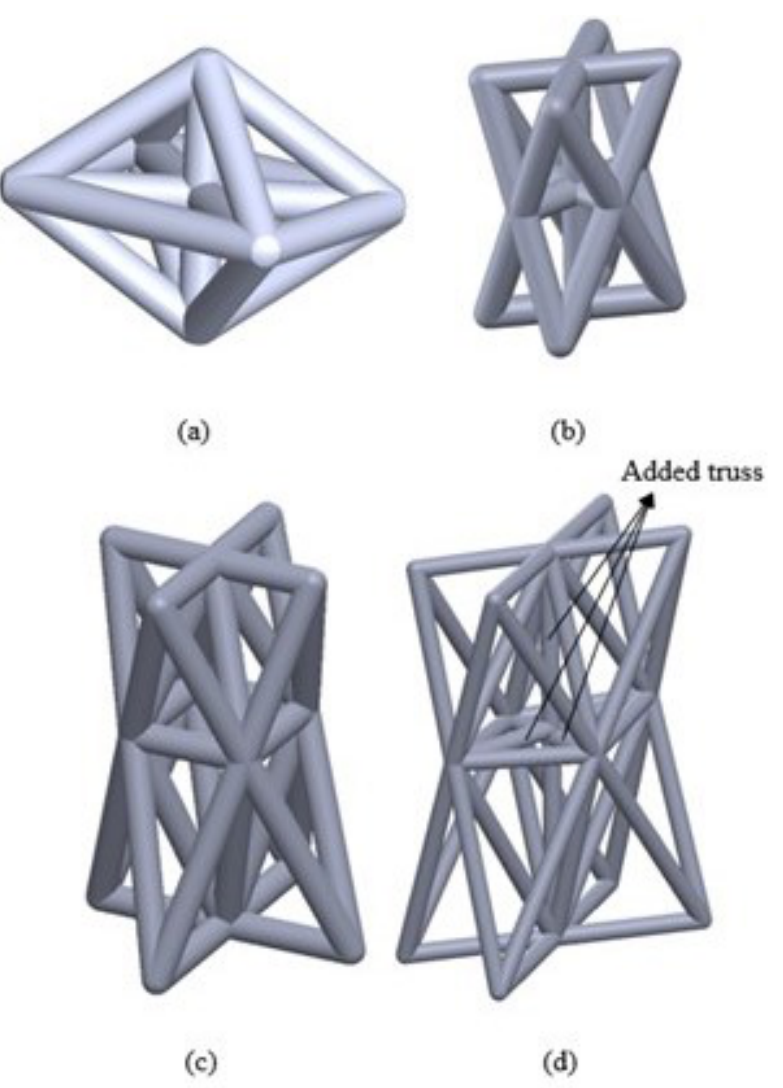
Figure 1. Four Lattice Structure Cell Model: ( a ) Octahedron-Cross (OHC). ( b ) Octet-Cross (OC). ( c ) Octet-Truss (OT). ( d )